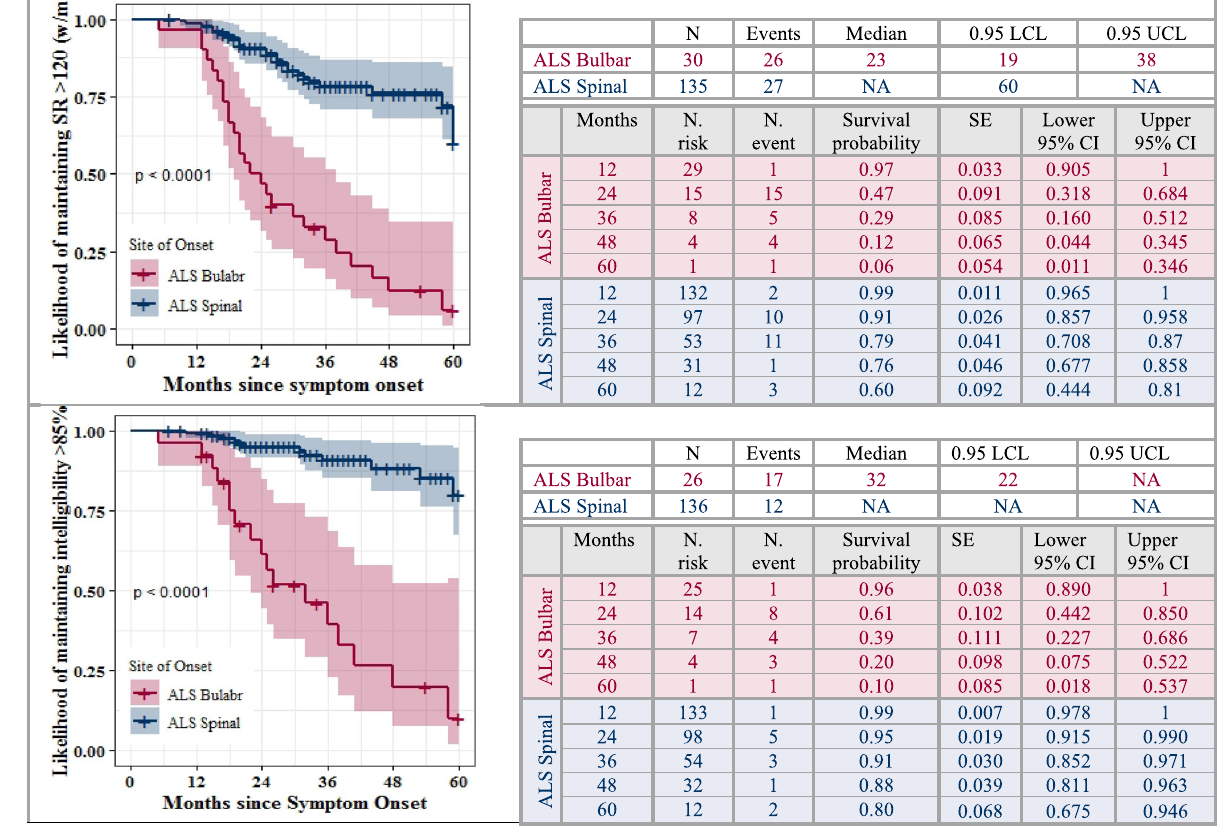
Figure 5. Kaplan–Meier curve and the corresponding estimates for time to speech loss defined as speaking rate below 120 (w/m) or intelligibility below 85%.